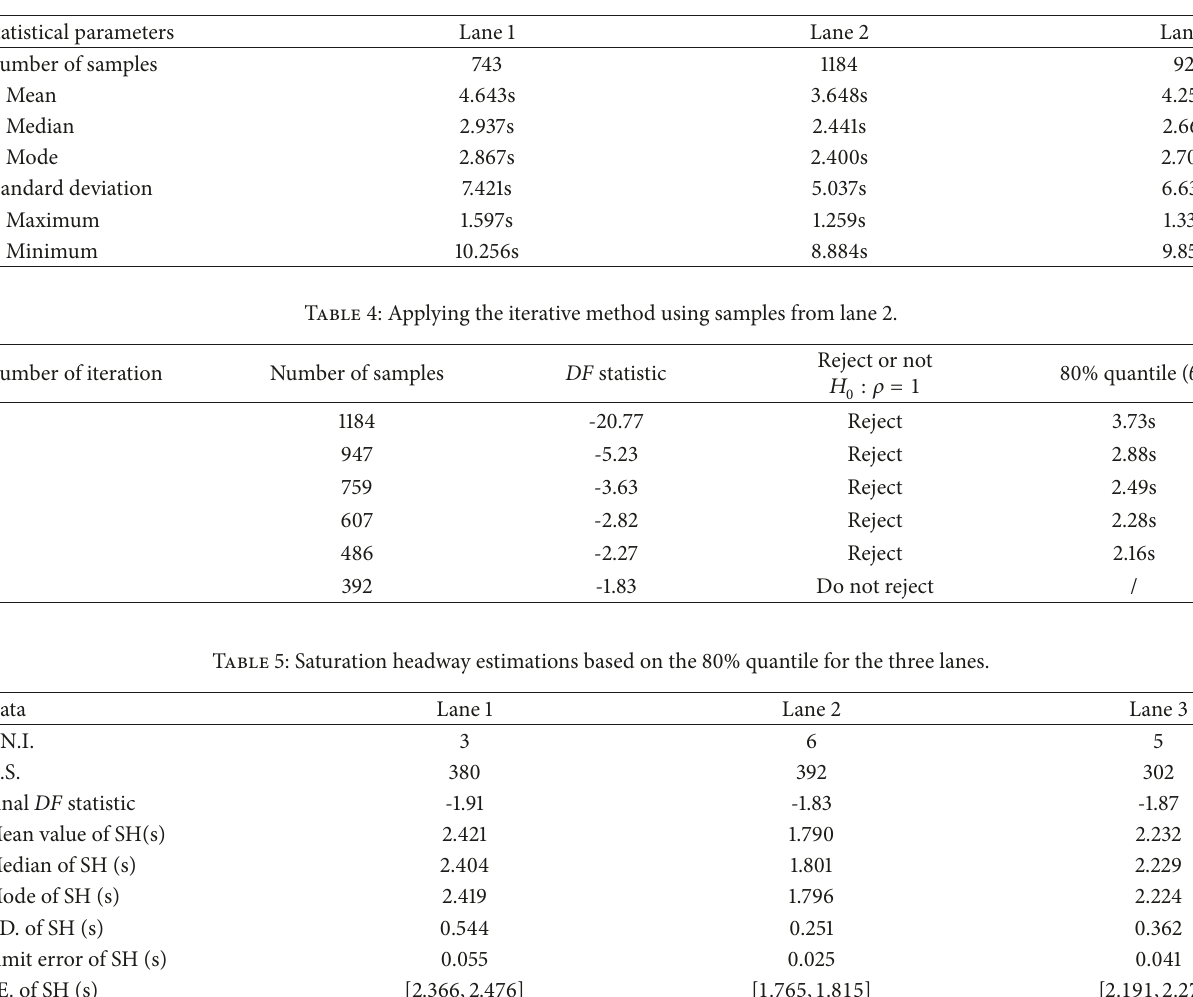
Table 3: Statistics of the samples after excluding the (a) type of abnormal data.